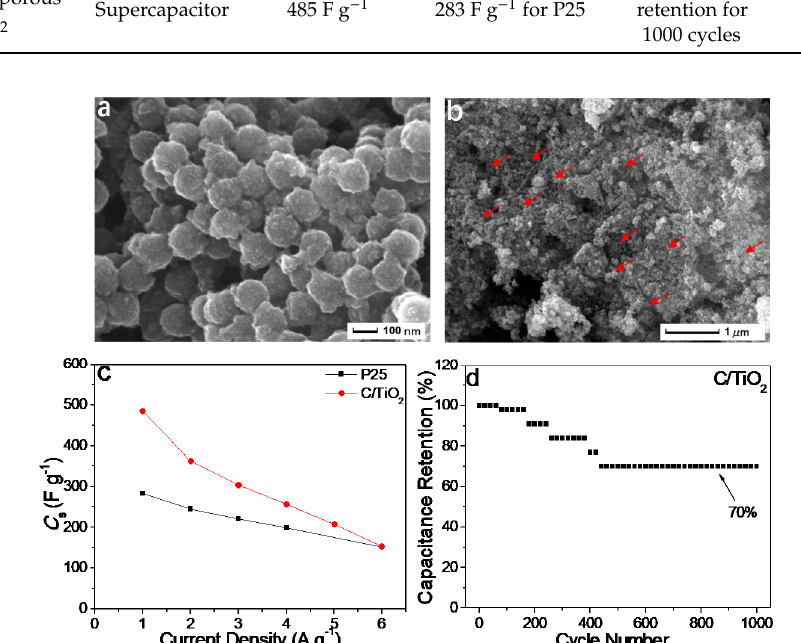
Figure 7. SEM ( a , b ) mages of C-doped porous TiO 2 electrodes, ( c ) comparative specific capacitances, and ( d ) cycling performance over 1000 cycles. Reprinted with permission from Ref. [42]. Table 3. The photocatalytic performance of C-doped TiO 2 materials toward the degradation of organic pollutants.